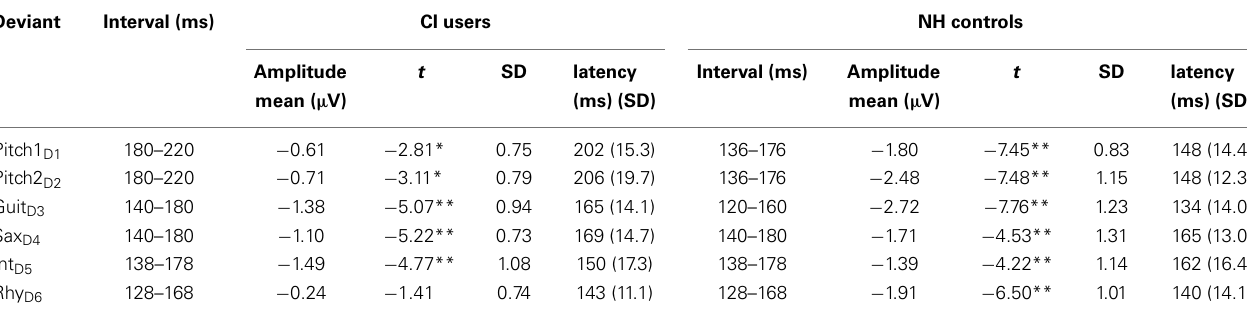
Table 2 |Amplitudes and latencies of the MMN in response to different musical features for both